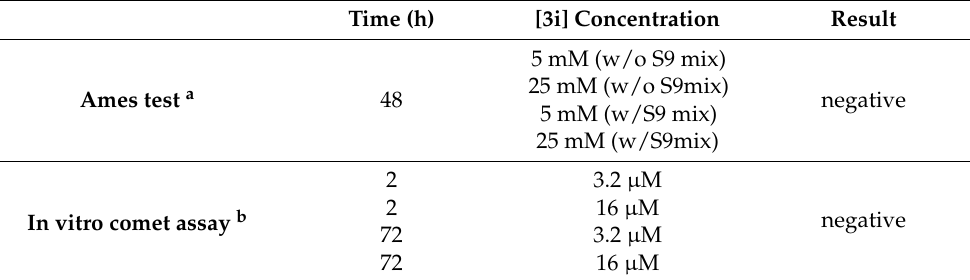
Table 3. Ames test and in vitro comet assay data regarding hit compound 3i .